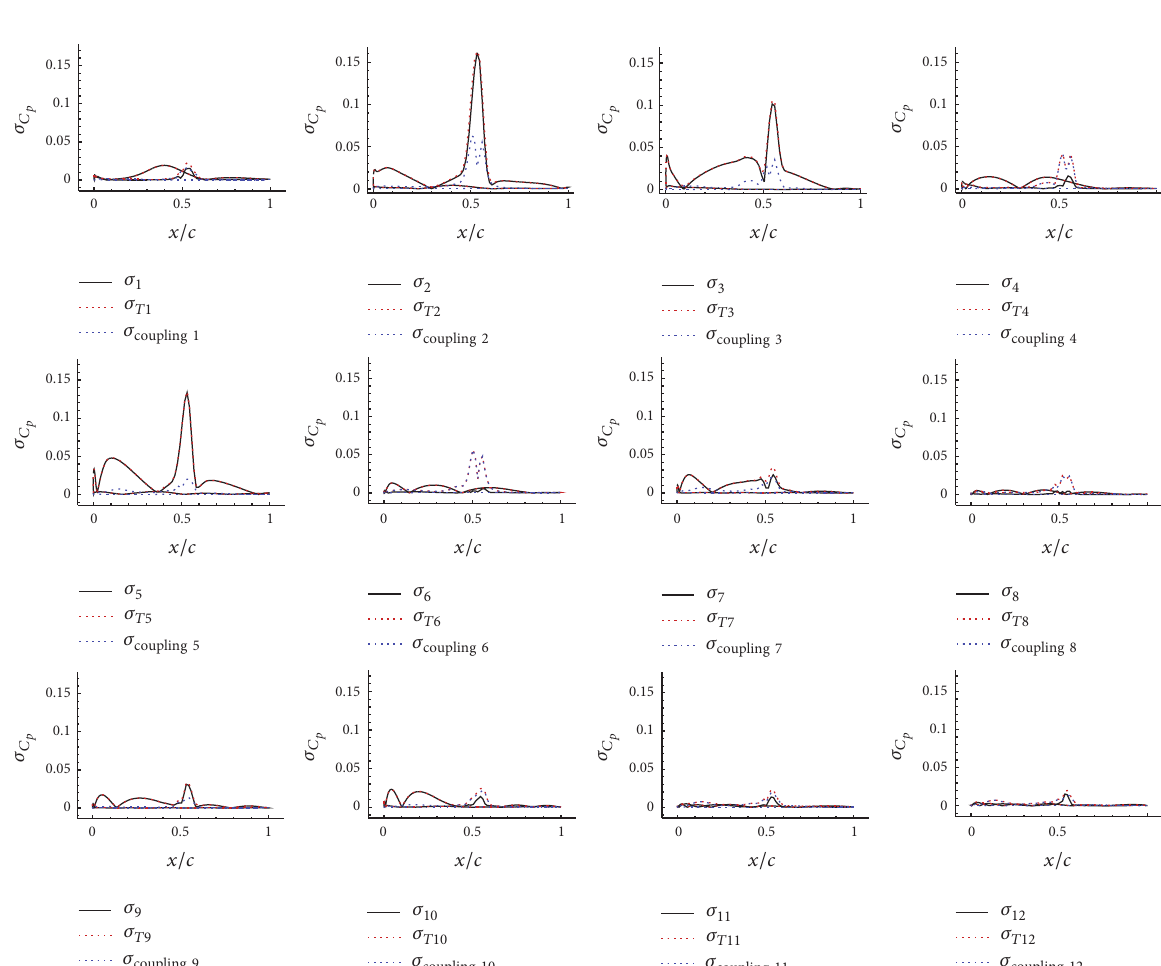
Figure 12: The results of 𝐶 𝑝 distribution by Sobol’s analysis ( 𝜎 𝑖 is the partial standard variation with uncertain variable 𝑖 ; 𝜎 𝑇𝑖 is the total partial standard variation with uncertain variable 𝑖 ; 𝜎